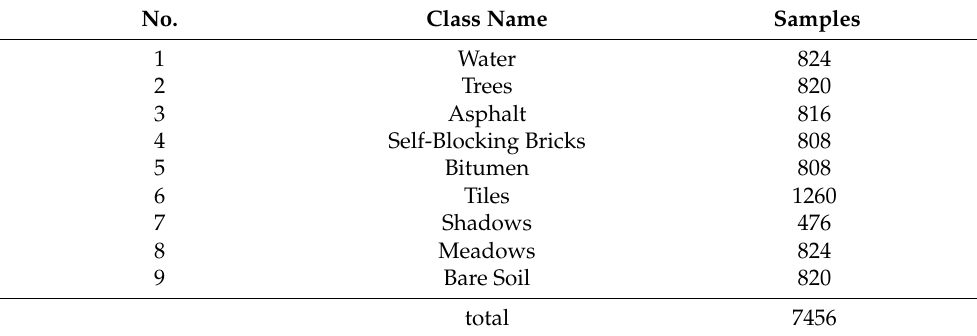
Table 4. Samples distribution for Pavia Center dataset.